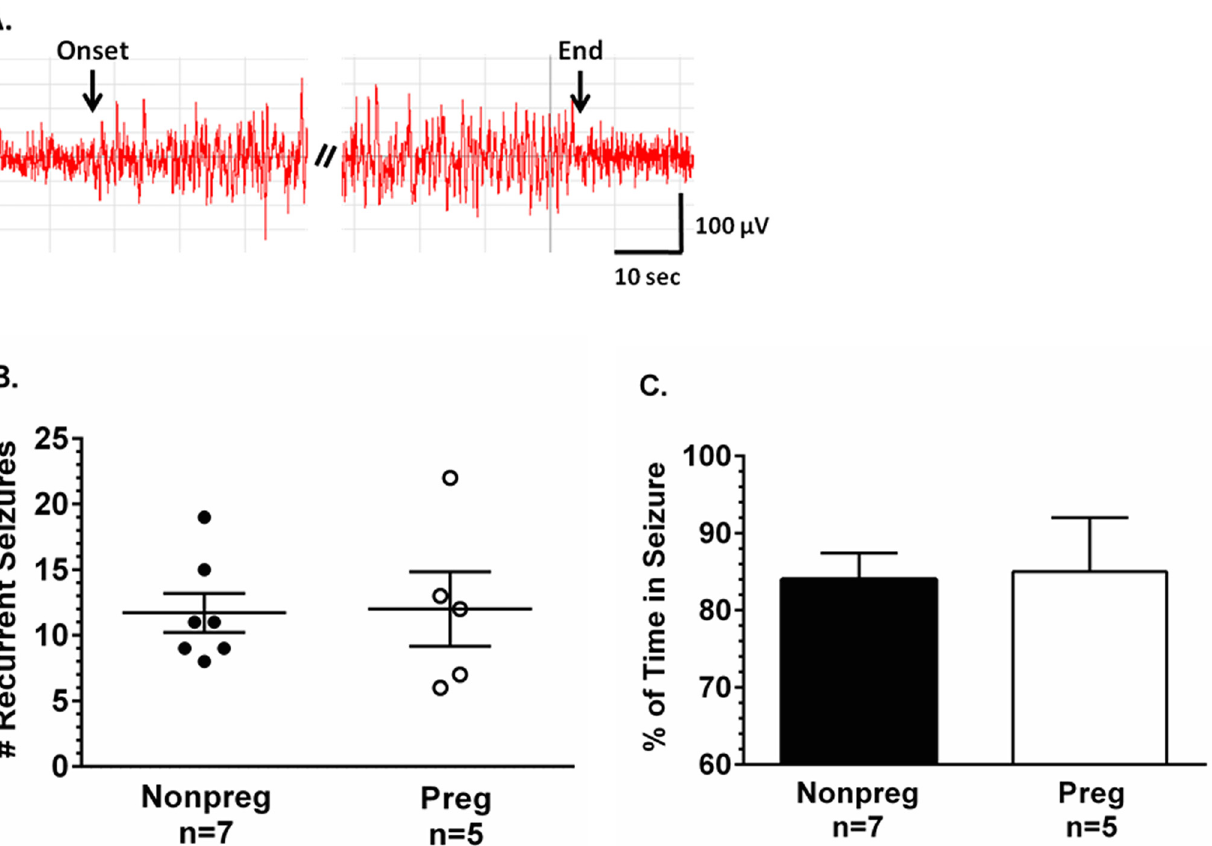
Fig 2. The effect of pregnancy on seizure severity. (A) Representative EEG tracing of a recurrent seizure during the 30-minute post-pentylenetetrazol (PTZ) infusion time period of a nonpregnant (Nonpreg) rat. Left black arrow indicates seizure onset and right black arrow seizure cessation. (B) Number of recurrent seizures in the 30-minute post-PTZ infusion period was similar between Nonpreg and late-pregnant (Preg) rats. (C) The percent of time spent in seizure during the 30-minute post-PTZ time period was similar between Nonpreg and Preg